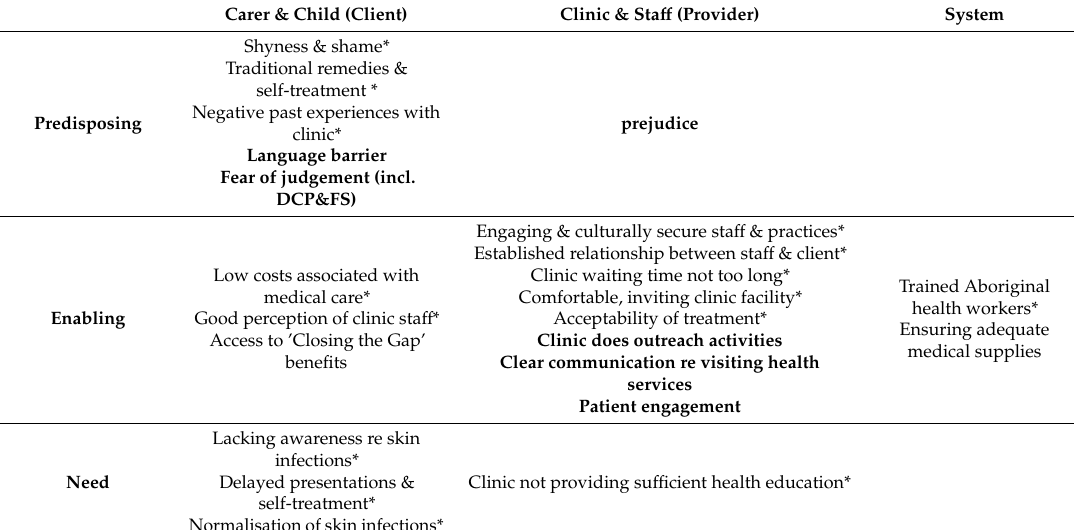
Table 3. Factors that a ff ect health service utilisation in remote Pilbara communities according to parents / carers.